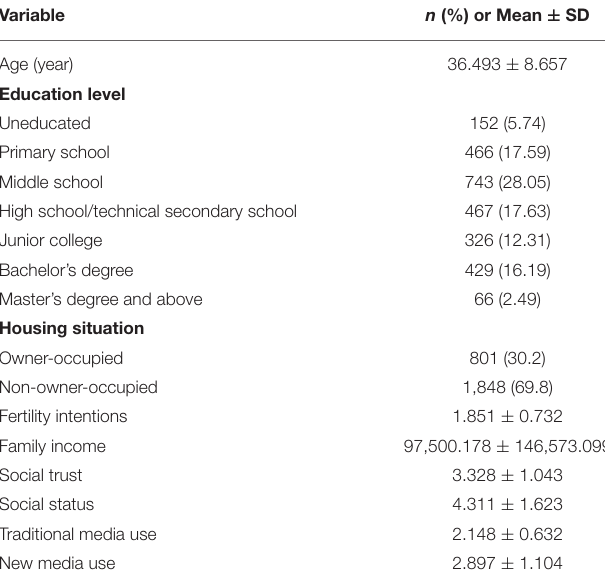
TABLE 1 | Sociodemographic information of the